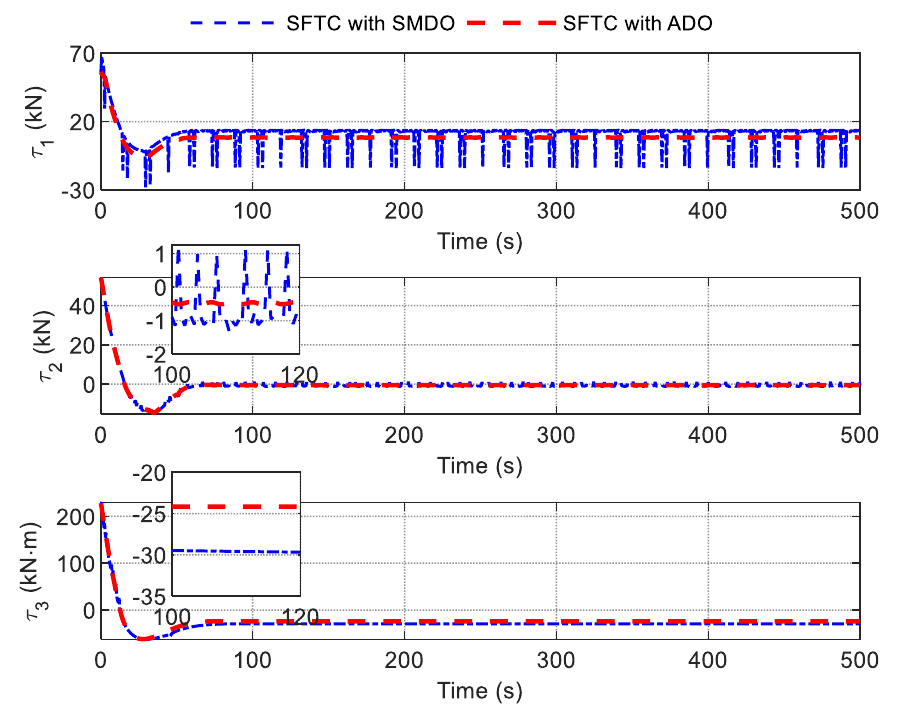
Figure 14. Comparison of control inputs.